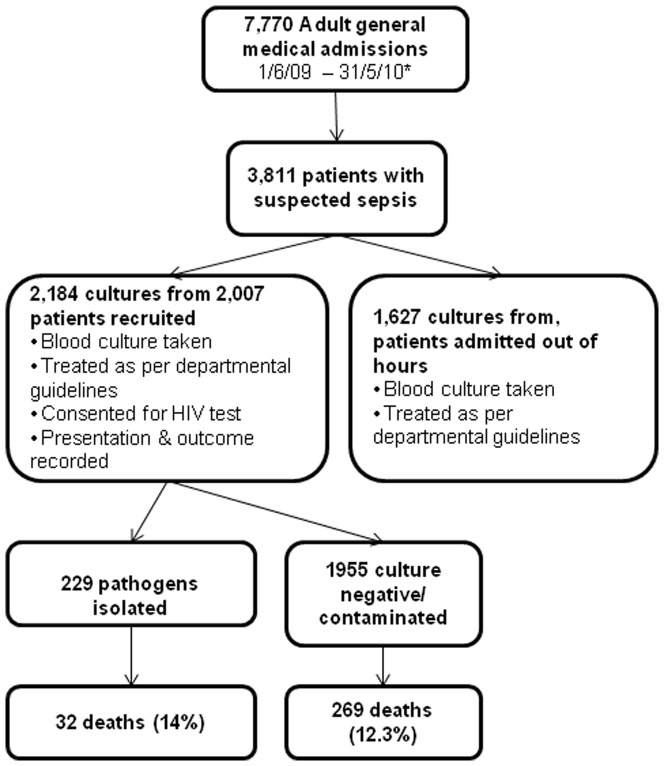
Summary of patient recruitment strategy and outcomes.